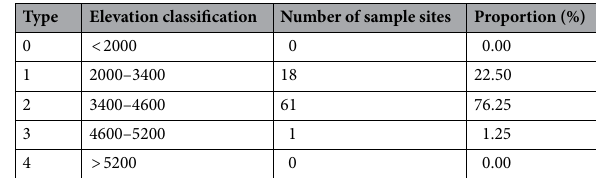
Table 3. Statistics on the number of sample sites classified by different elevations.